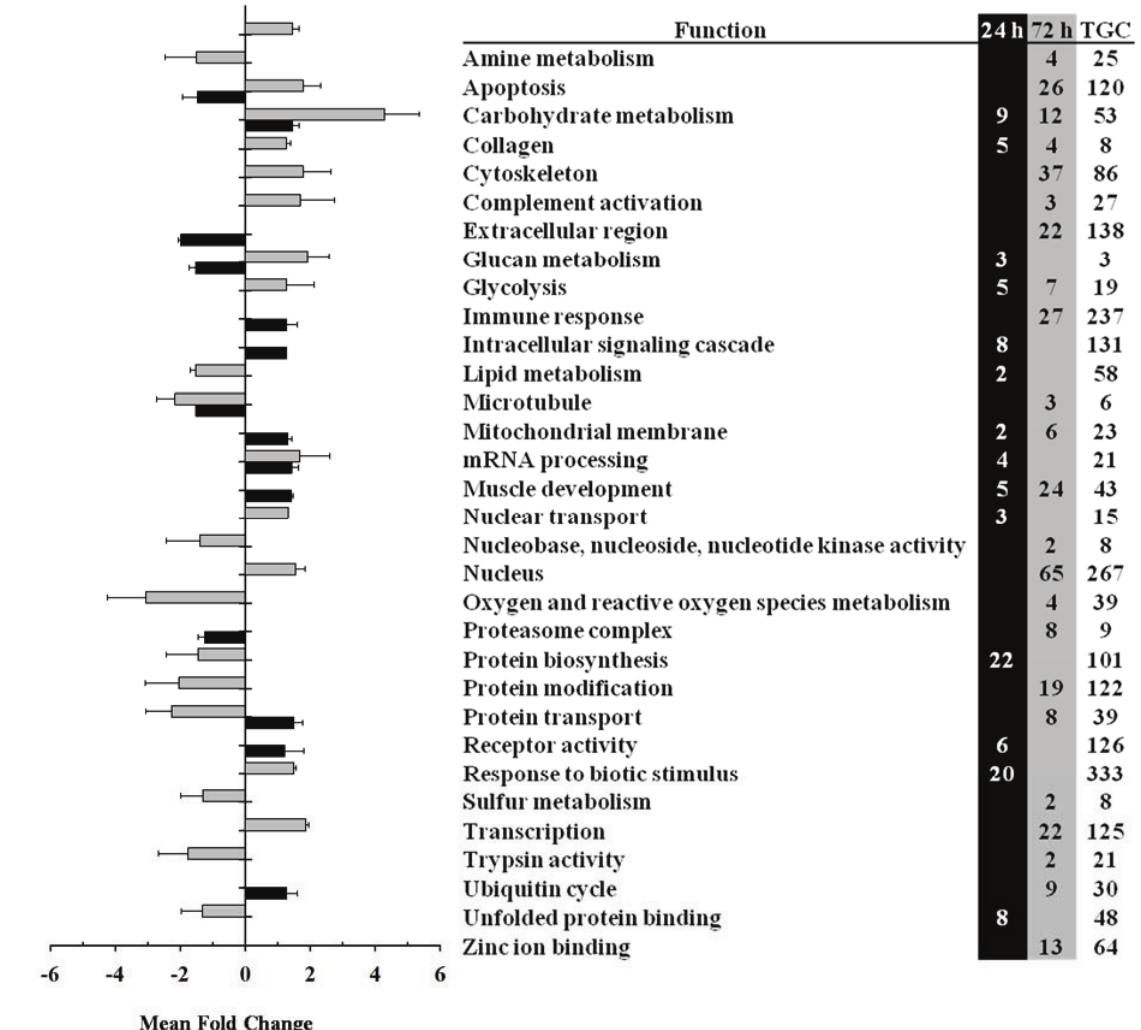
Figure 3. Gene ontology analyses of genes expressed in fast skeletal muscle at 24 h (black bars) and 72 h (grey bars) after lipopolysaccharide (LPS) administration in trout. Differentially expressed genes (DEGs) were grouped by gene ontology functional categories and fold change differences were analyzed by Student’s t -test ( p < 0.05). TGC indicates the total number of genes included in each functional category. Data are shown as mean fold